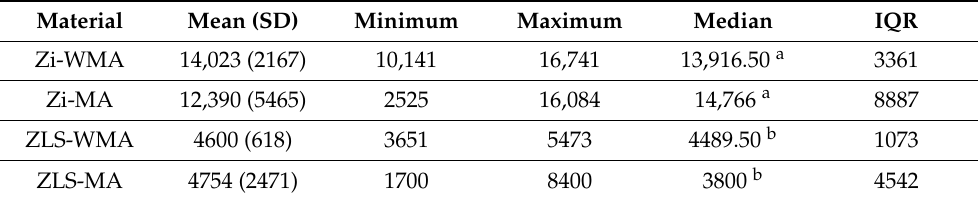
Table 4. Mean (SD), median (IQR) of the fracture load of Zi and ZLS crowns, with (MA) and without mechanical aging (WMA), in Newtons (N) (n = 8).